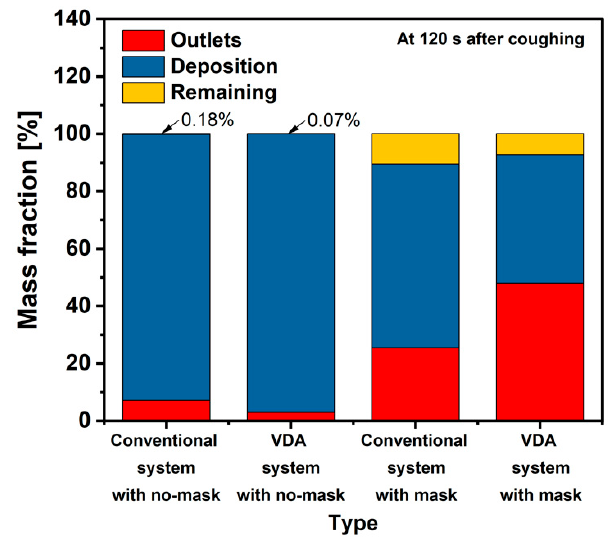
Figure 17. Proportion of droplets in the conventional and VDA systems with and without the mask 120 s after coughing.